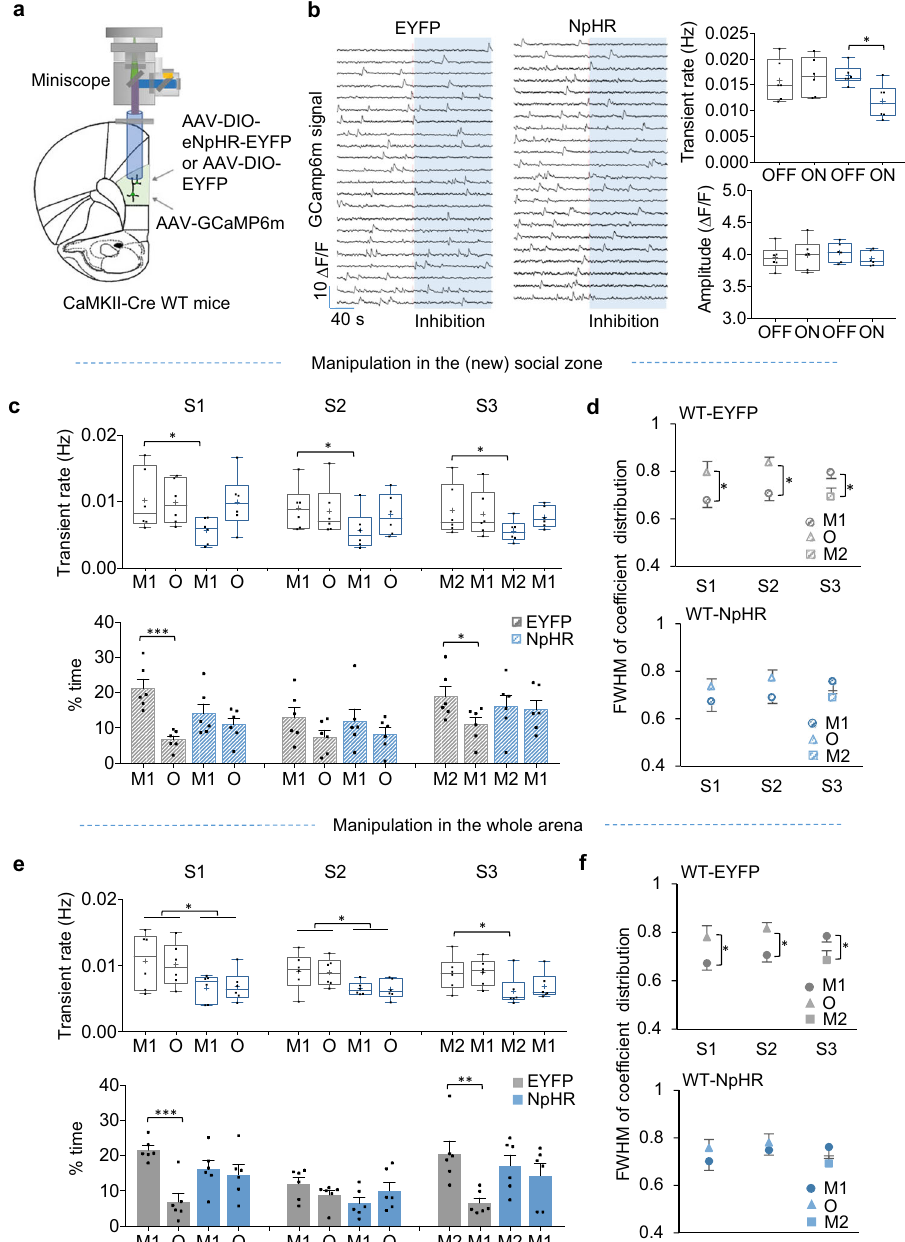
Fig. 6 Inhibiting mPFC pyramidal neuron activity impairs social preference in WT mice. a Diagram showing virus injection and lens implantation in the PL region for microscope enabling simultaneous optogenetic inhibition and imaging of pyramidal neurons of the CaMKII-Cre WT ( Mecp2 + / + ) mice. b Sample calcium traces (left), transient rate, and amplitude (right) of PL pyramidal neurons in NpHR or EYFP mice recorded in their home cage with and without optogenetic inhibition. The shaded area represents the period with the optogenetic light on. NpHR: n = 6 mice; EYFP: n = 6 mice. c Social-zone manipulation of mPFC reduced preference for the social novelty of NpHR WT mice (top) and inhibited their transient rate (bottom) in the stimulated zone. * P < 0.05, *** P < 0.001, NpHR ( n = 6) versus EYFP ( n = 6), two-way ANOVA with post hoc Bonferroni correction. d The averaged FWHM of correlation distribution of EYFP ( n = 6) and NpHR ( n = 6) WT mice during interactions with different stimuli. Data are represented as mean ± SEM. * P < 0.05, two-way RM ANOVA with Bonferroni – corrected post hoc comparisons. e The whole-arena stimulation of mPFC more severely impaired the sociability and social novelty preference (top) and decreased the transient rate (bottom) of NpHR mice ( n = 9), compared with EYFP mice ( n = 8). Error bars indicate SEM. * P < 0.05, ** P < 0.01, *** P < 0.001, NpHR ( n = 6) versus EYFP ( n = 6), two-way ANOVA with post hoc Bonferroni correction. f Whole-arena manipulation of the mPFC impaired pattern decorrelation between two stimuli in NpHR WT mice. NpHR: n = 6 mice; EYFP: n = 6 mice. Error bars indicate SEM. * P < 0.05, two-way RM ANOVA with Bonferroni – corrected post hoc comparisons. Box boundaries in ( b ), ( c ), and ( e ) are the 25th and 75th percentiles, the horizontal line across the box is the median, the cross “ + ” indicates the mean value, and the whiskers indicate the minimum and maximum values. Source data are provided as a Source Data fi